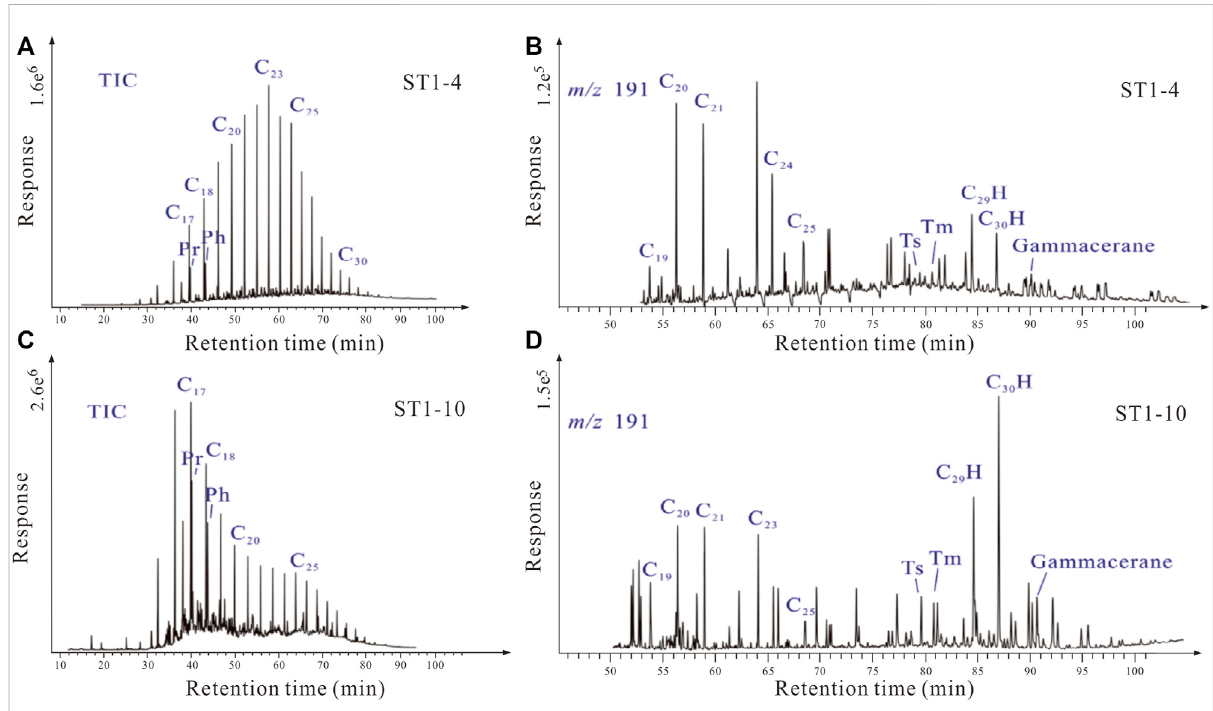
FIGURE 7 (A – C) Chromatograms and (B – D) mass spectrograms (with m / z ratio of 191) of crude oil samples from the P 3 w Formation. Pr: pristane, Ph: phytane. (A) Acompletesequenceof n -alkanesinthetotalionchromatogram(TIC)ofST1-4oilsample. (B – D) 25-norhopaneswerenotfoundin m / z